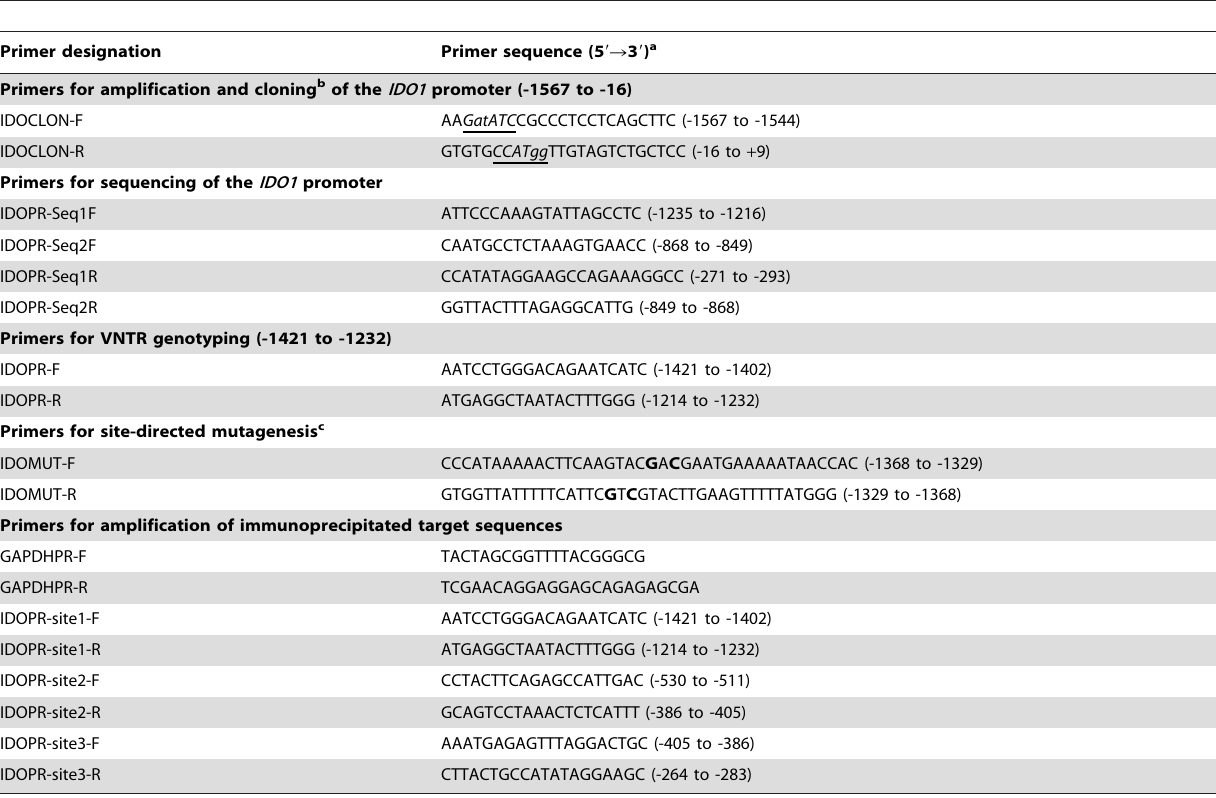
Table 1. Primers used for IDO1 promoter sequencing, VNTR genotyping, site-directed mutagenesis and post-ChIP PCR.